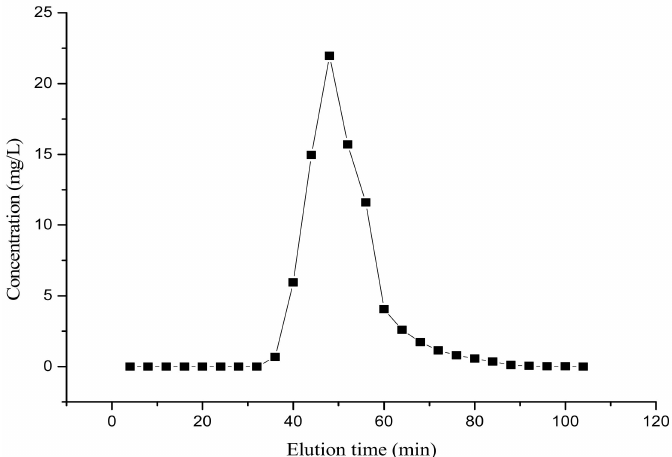
Figure 9. Dynamic de-adsorption curve of XDA-1 resin for the amygdalin.